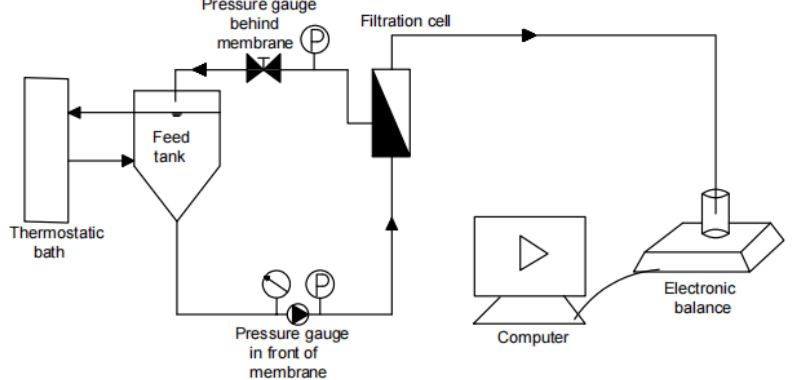
Figure 2. High-pressure NF crossflow filtration